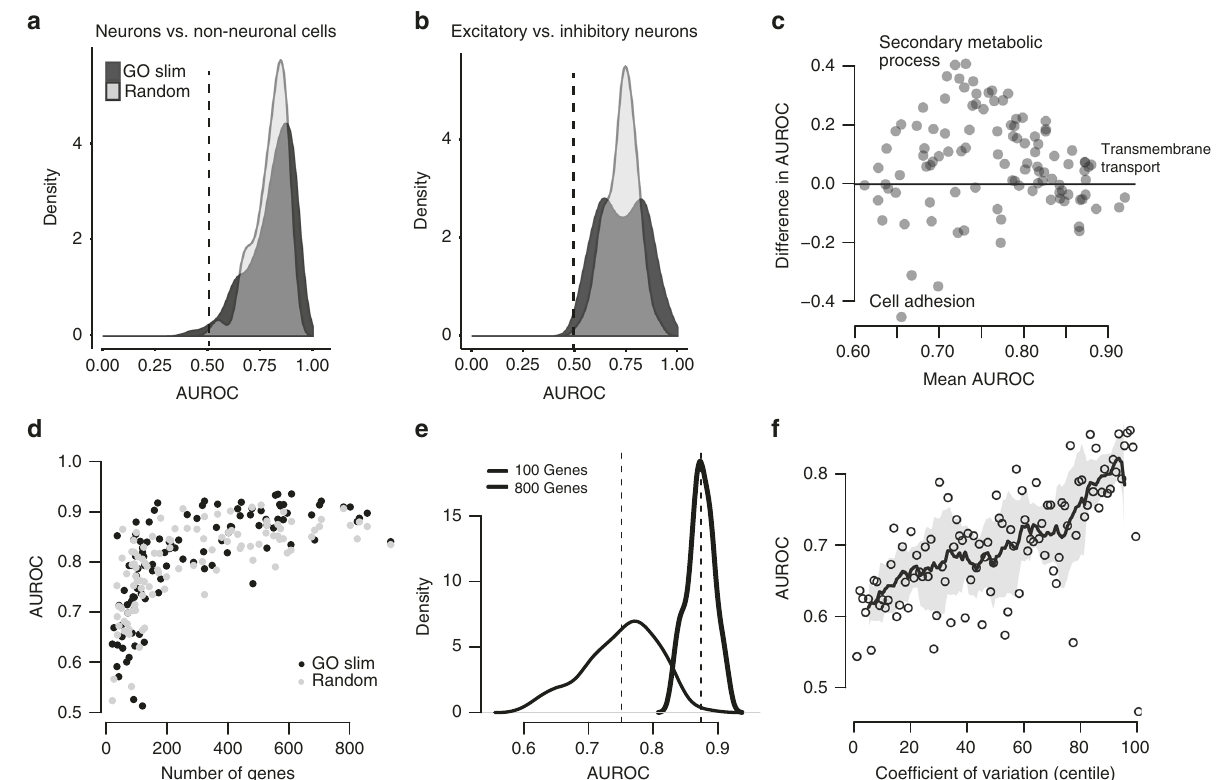
Fig. 2 Cell-type identity is widely represented in the transcriptome. a , b Distribution of AUROC scores from MetaNeighbor for discriminating neurons from non-neuronal cells ( “ task one ” , a ) and for distinguishing excitatory vs. inhibitory neurons ( “ task two ” , b ). GO scores are in black and random gene set scores are plotted in gray. Dashed gray lines indicate the null expectation for correctly guessing cell identity (AUROC = 0.5). For both tasks, almost any gene set can be used to improve performance above the null, suggesting widespread encoding of cell identity across the transcriptome. c Comparison of GO group scores across tasks. GO groups at the extremes of the distribution are labeled. Most gene sets have higher performance for task one, and a number of groups have high performance for both tasks (e.g., transmembrane transport). d Task one AUROC scores for each gene set are plotted with respect to the number of genes. A strong, positive relationship is observed between gene set size and AUROC score, regardless of whether genes were chosen randomly or based on shared functions. e Distribution of AUROC scores for task one using 100 sets of 100 randomly chosen genes, or 800 randomly chosen genes. The mean AUROC score is signi fi cantly improved with the use of larger gene sets (mean 100 = 0.80 ± 0.05, mean 800 = 0.90 ± 0.03). f Relationship between AUROC score and coef fi cient of variation. Points indicate individual gene set performances, the line shows the running average and the SD of the line is indicated by the shaded region. Task one was re-run using sets of genes chosen based on mean coef fi cient of variation across datasets. A strong positive relationship was observed between this factor and performance ( r s ~